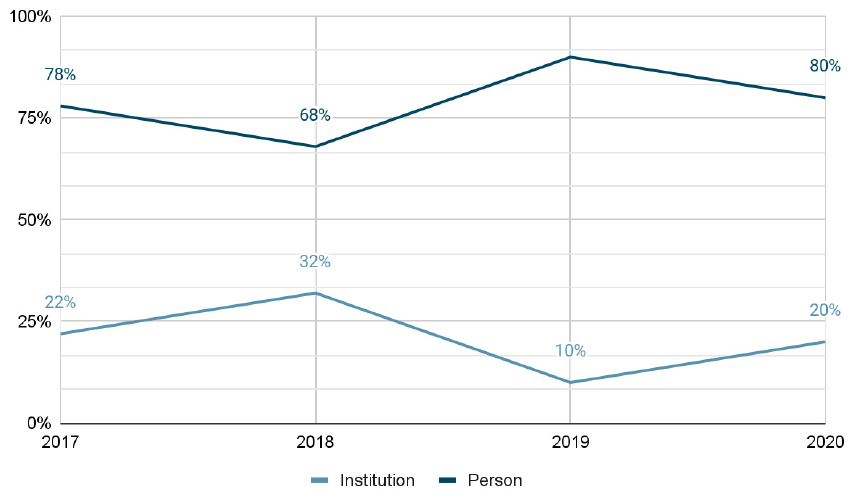
Figure 4. Institutions vs. people percentages that the sample of Spanish deputies started to follow in 2017, 2018, 2019 and 2020.